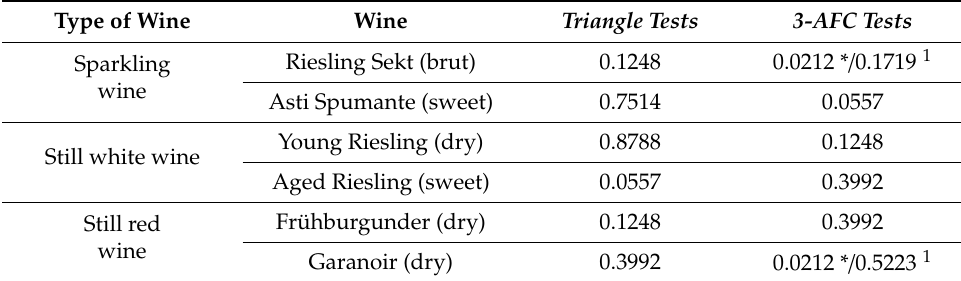
Table 3. Resultsof triangle and 3-AFC sensoryanalysistests: alpharisksandsignificantdifferences(* p <